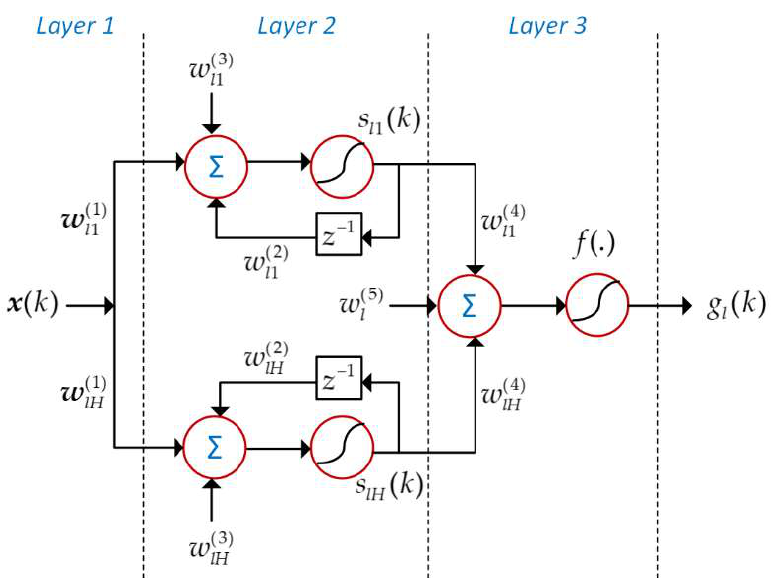
Figure 1. Configuration of the consequent part of a fuzzy rule.